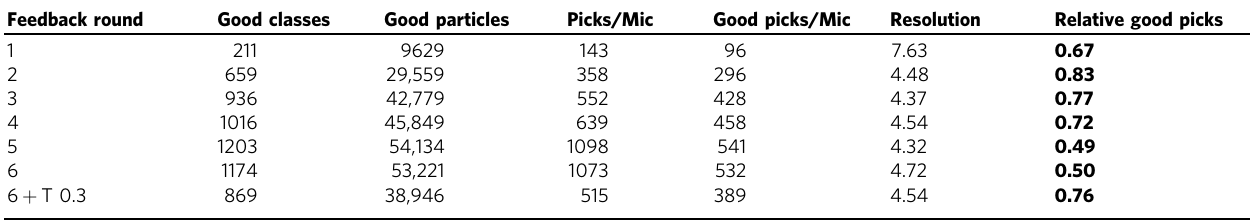
Table 5 Summary of the feedback loop statistics for the actomyosin complex. Feedback